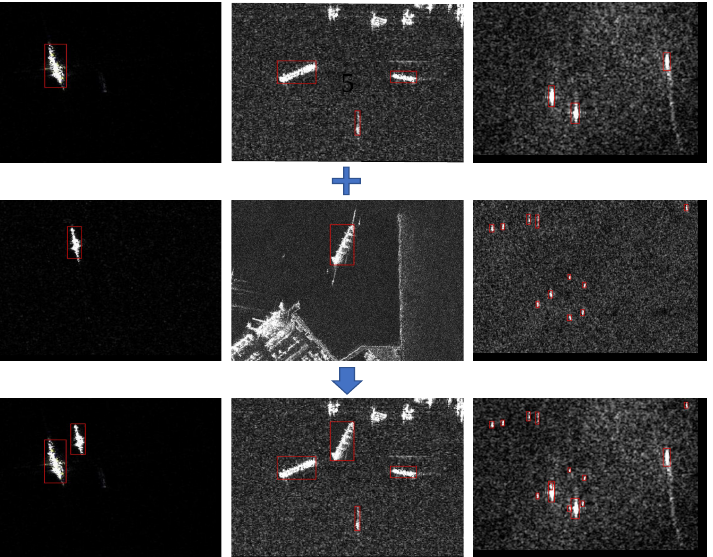
Figure 5. Examples of the created training images by BoxPaste. By copying the bounding boxes of the middle image and pasting them into the top image, we get the bottom image. One can see that BoxPaste can effectively increase the number of ground-truth ship objects per